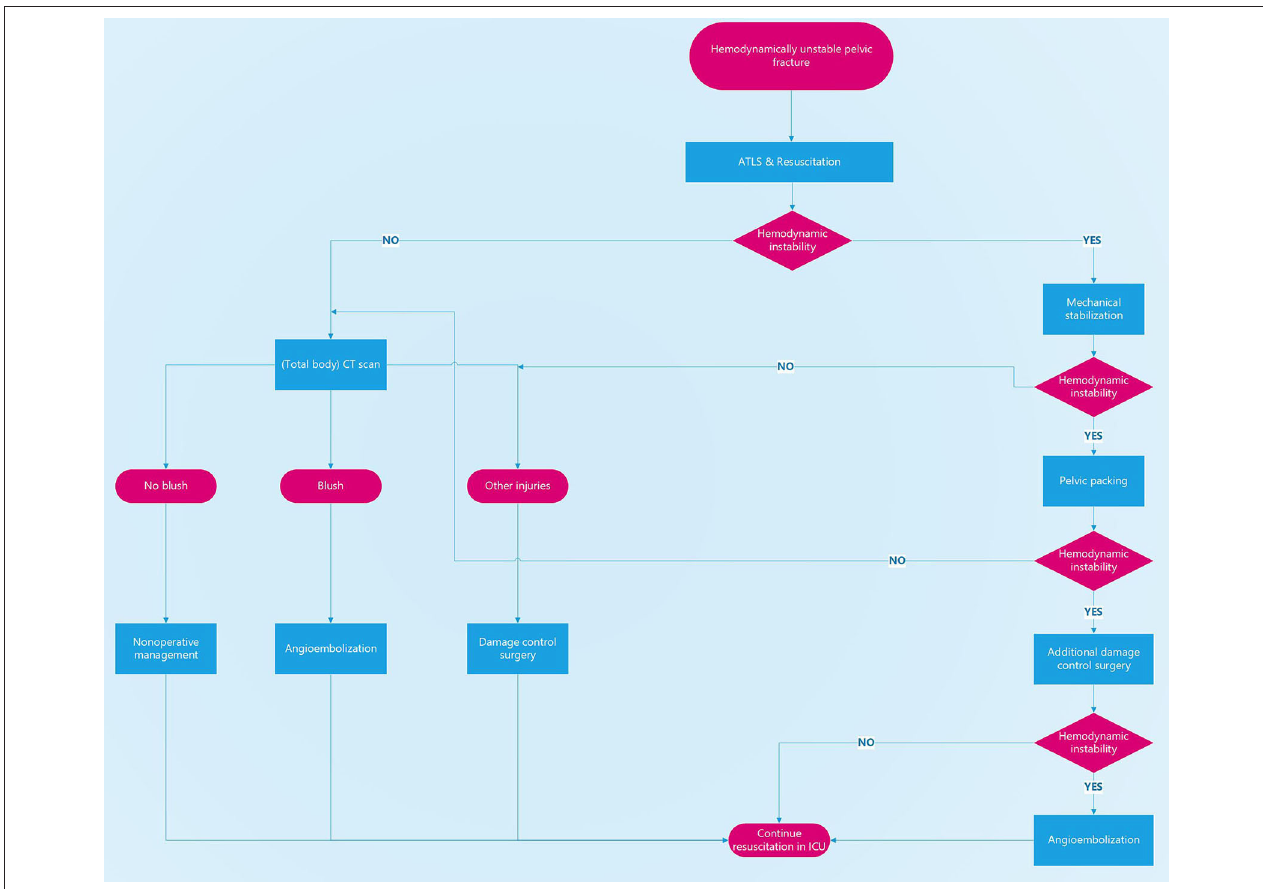
FIGURE 1 | Treatment algorithm for hemodynamically unstable pelvic fractures. Decision-making is based on the patient’s physiological status. Hemodynamically unstable patients should not be taken to a CT scanner or to the angio suite but to the operating theater for mechanical stabilization, pelvic packing, and additional damage control surgery if needed.